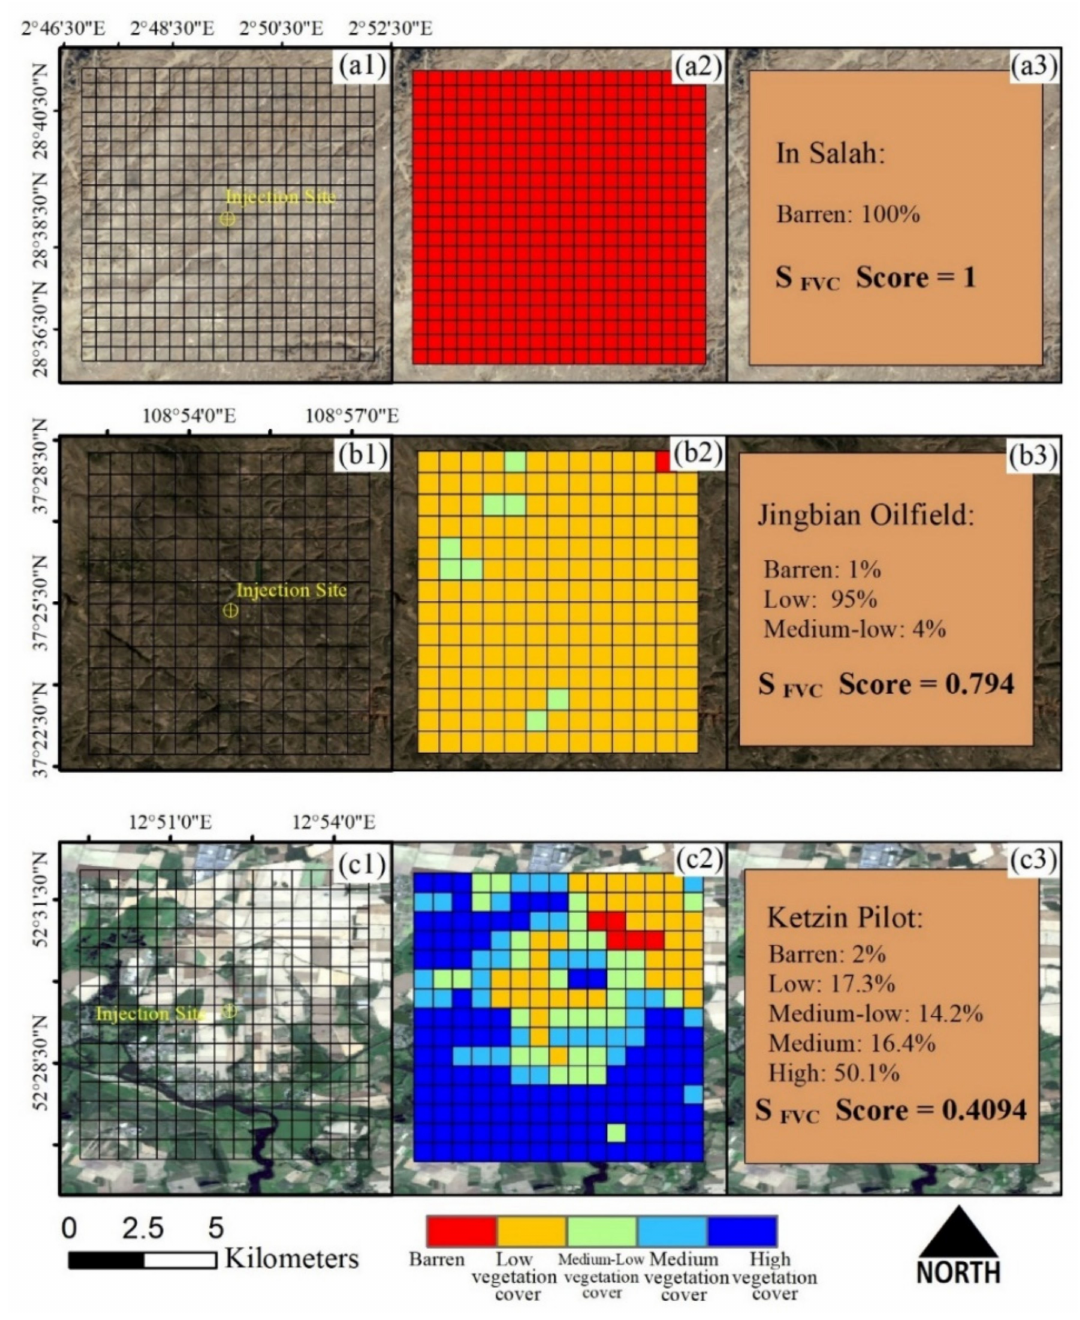
Figure 2. The graphs show the vegetation coverage of Salah, Jingbian, and Ketzin. The base map is the true color composite image of LANDSAT 8 OLI. ( a1 – c1 ) show the location of the injection wells and their buffers in the study area. ( a2 – c2 ) show their corresponding FVC index with a resolution of 500 m. ( a3 – c3 ) illustrate the proportion of the vegetation coverage classification in each study area, and their S FVC